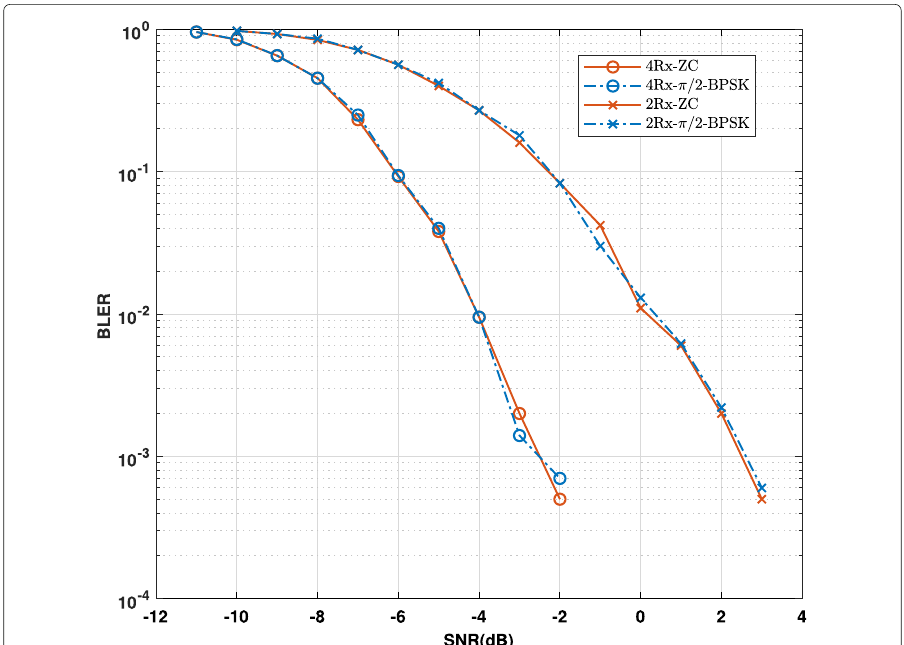
Fig. 17 BLER comparison of length-96 ZC and π/ 2-BPSK DMRS